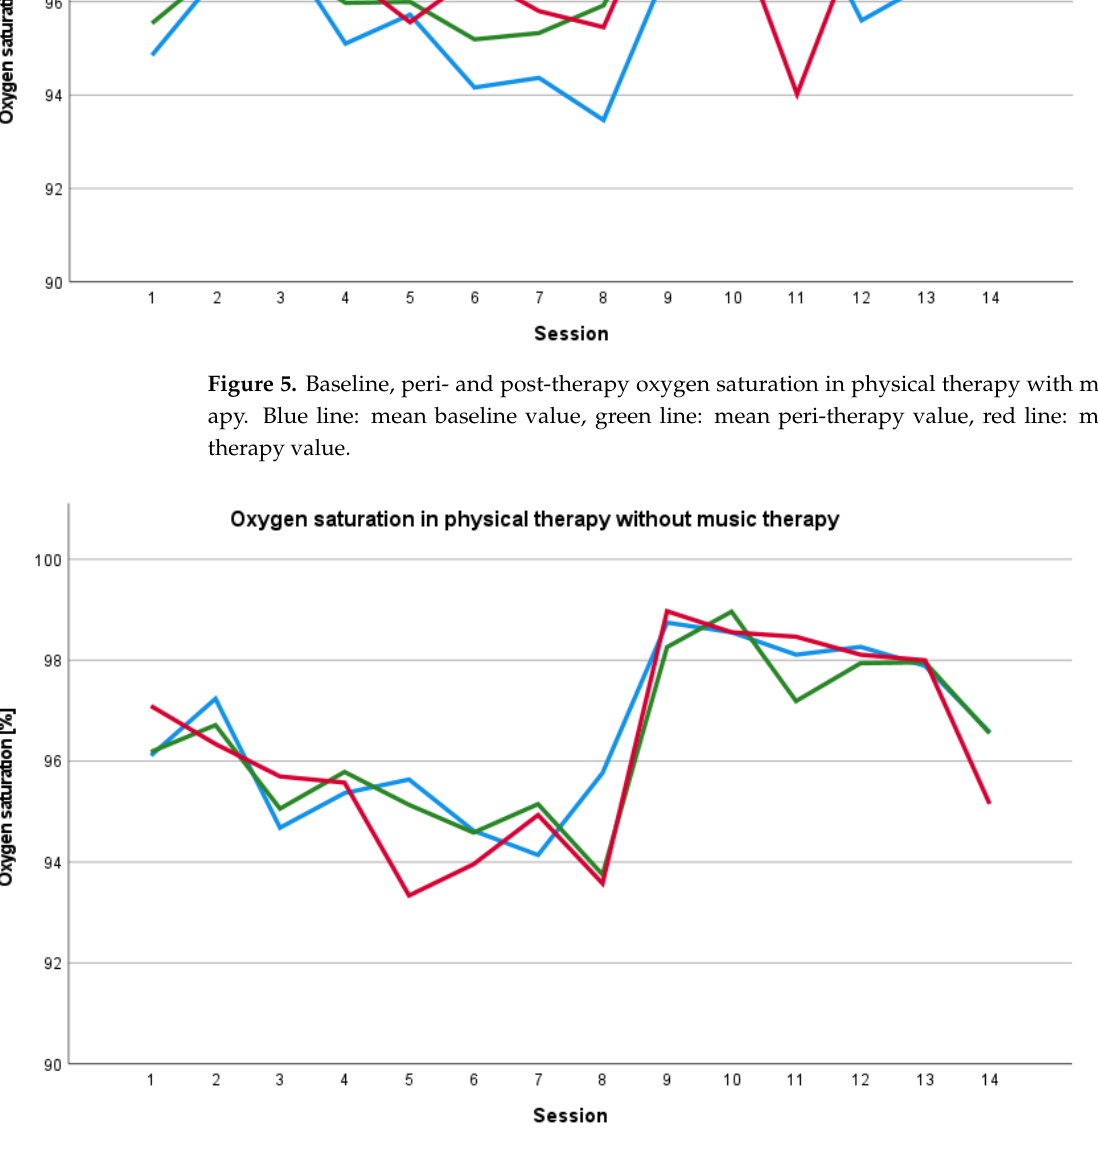
Figure 6. Baseline, peri- and post-therapy oxygen saturation in physical therapy without music therapy. Blue line: mean baseline value, green line: mean peri-therapy value, red line: mean post-therapy value.